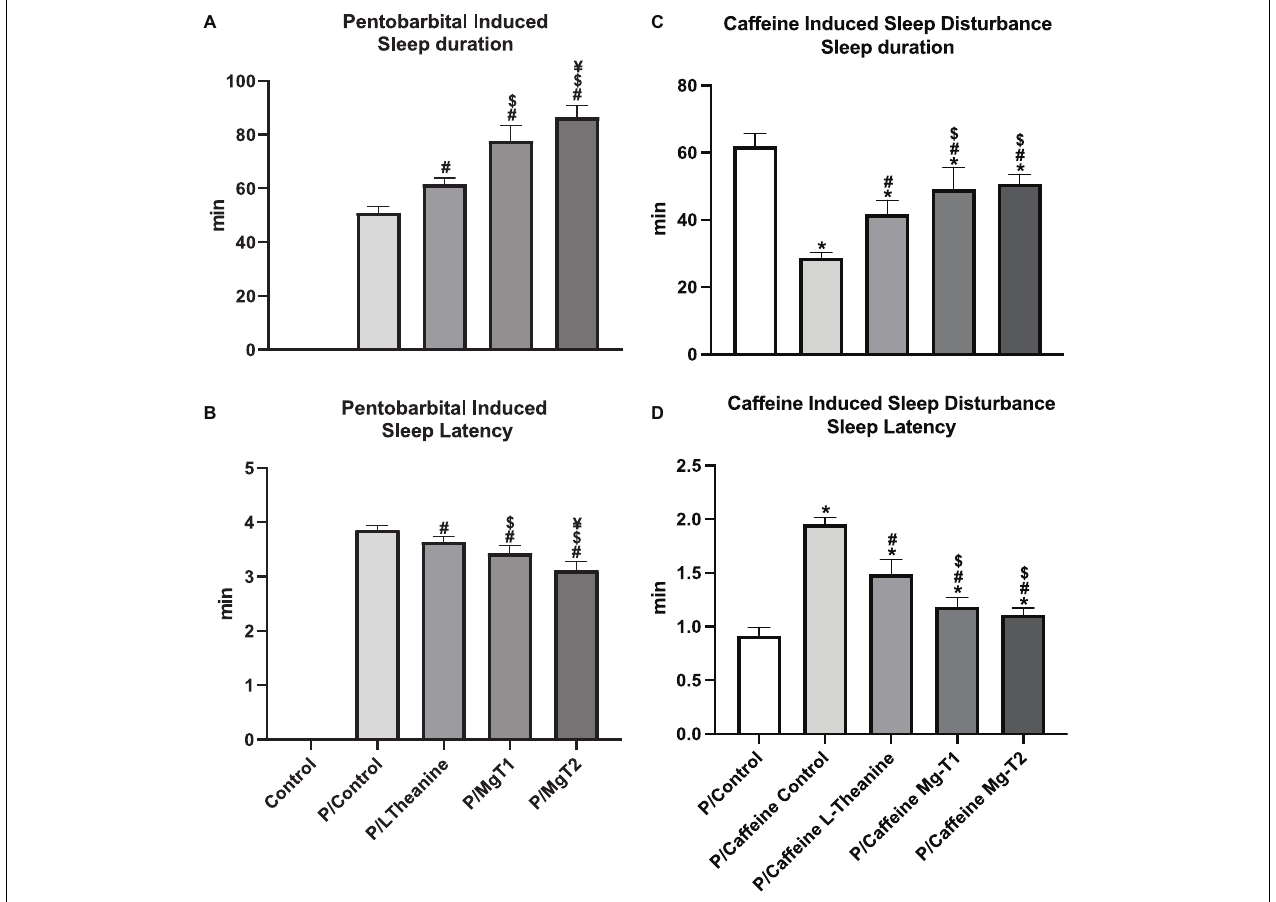
FIGURE 6 | L -Theanine and Mg- L -theanine compounds increase sleep duration and de-crease sleep latency. Effects of L -theanine and Mg-T compounds on sleep duration (A) and sleep latency (B) after pentobarbital administration. The same test was applied in the caffeine-induced sleep disturbance model (C,D) . ANOVA with Tukey’s HSD was performed for multiple comparisons and values are represented as mean ± SD. * p < 0.05: compared to control, # p < 0.05: compared to caffeine control, $ p < 0.05: compared to L -theanine, (cid:85) p < 0.05: compared to